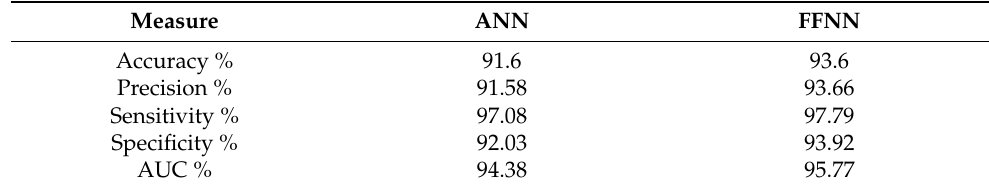
Table 3. Training parameter options for the CNN models.